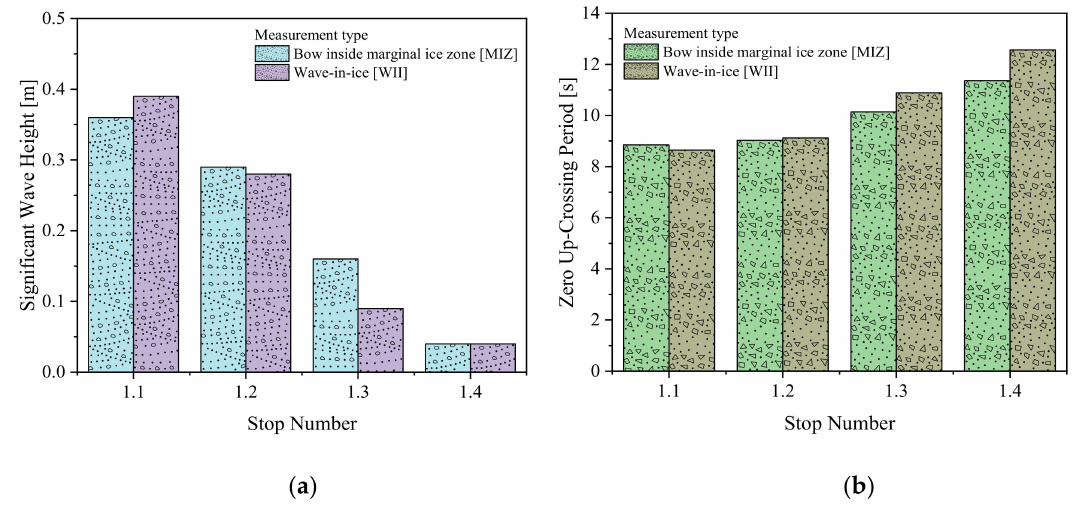
Figure 18. Measurements of the bow and WII: ( a ) wave height and ( b ) crossing period (based on data in [105]).